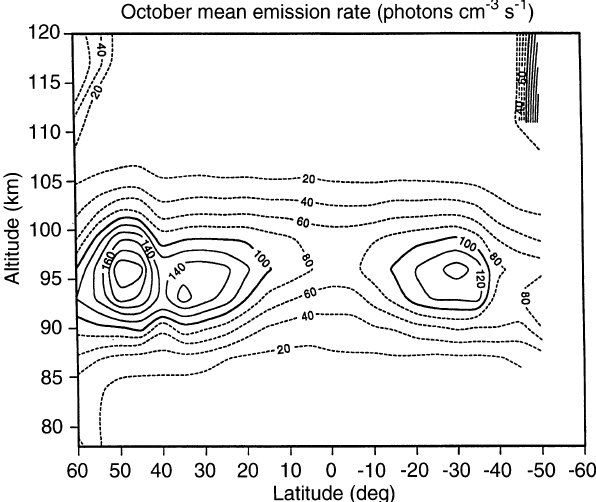
Fig. 10. Latitude-height distribution of the mean green-line emission rate in October